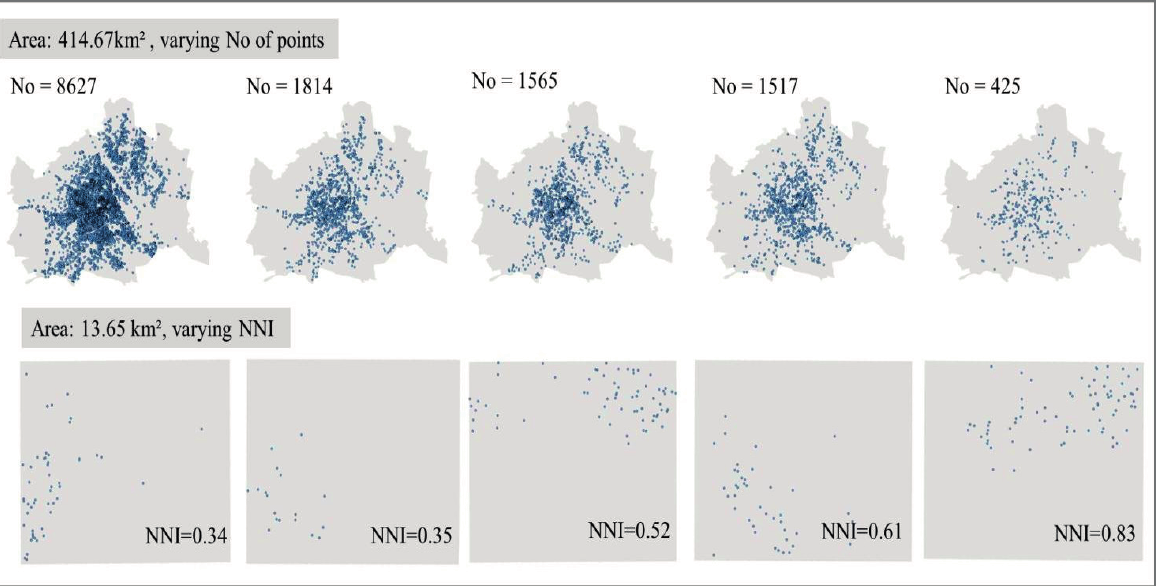
Figure 1. Original maps. The five maps at the top cover the entire city of Vienna (414.67 km 2 ) and vary in terms of the density of the points. The five maps at the bottom are squared areas in Vienna, each 13.65 km 2 large, and varying in terms of the distribution of the points and the clustering degree (NNI, nearest neighbor